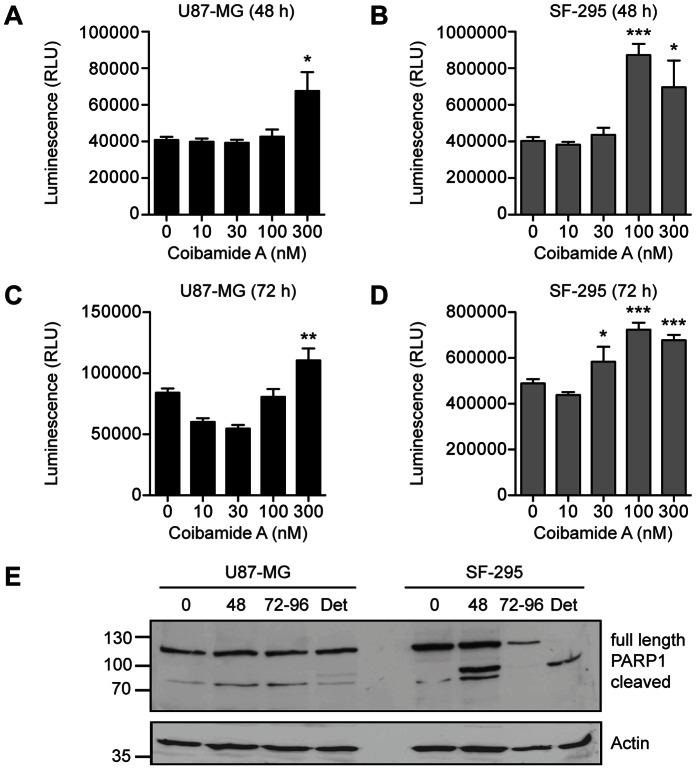
Coibamide A induces activation of caspase-3,7 and apoptosis in a cell type-specific manner.Concentration-response relationship for coibamide A-induced caspase-3,7 activation in (A) U87-MG and (B) SF-295 cells exposed to coibamide A (10–300 nM) or vehicle (DMSO) for 48 h. Coibamide A-induced caspase-3,7 activation in (C) U87-MG and (D) SF-295 cells exposed to coibamide A (10–300 nM) for 72 h. Caspase-3,7 activity was measured at the end of each treatment using a luminescence-based assay coupled with automated luminescence detection. Histograms represent mean ± SE of up to four independent determinations (**P<0.01 and ***P<0.001, coibamide A vs. vehicle control). (E) Immunoblot analysis of PARP1 in coibamide A-treated (100 nM) U87-MG and SF-295 cells lystates. Adherent and detached (Det) cells were harvested over 4 days and examined for expression of the large 89 kDa fragment of PARP1, a marker of apoptosis, plus actin as a loading control. Immunoblot is representative of an experiment repeated at least three times with similar results.